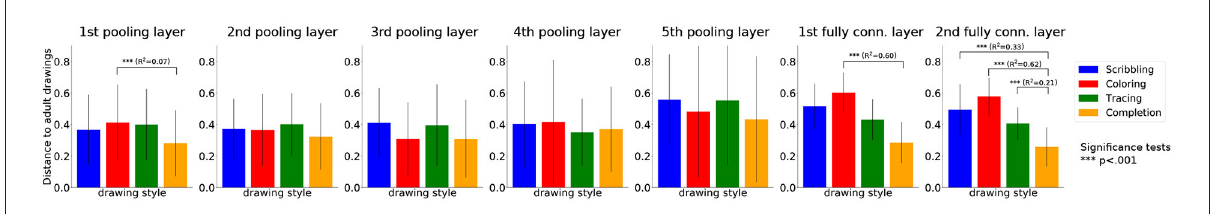
FIGURE7 Average distance of drawings that received an average rating of above 70 for a specific drawing style to adult drawings, for four different drawing styles. The distance was computed in either of seven different layers of the CNN. Significant differences are shown which hold for a cut-off of 60, 70, as well as